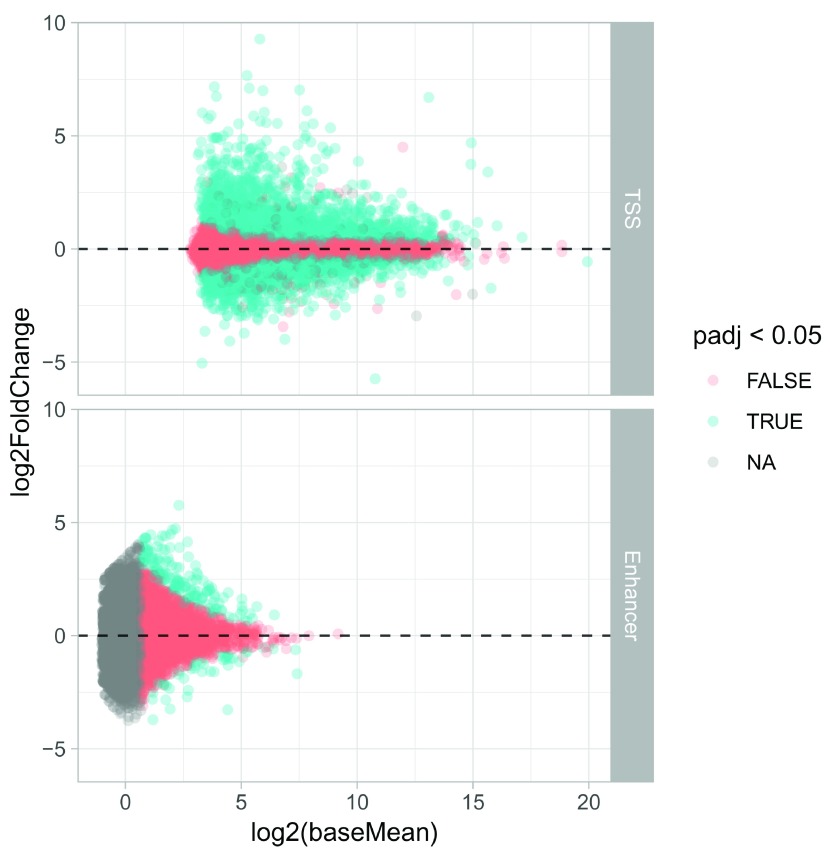
Diagnostic MA plot of the differential expression analysis.